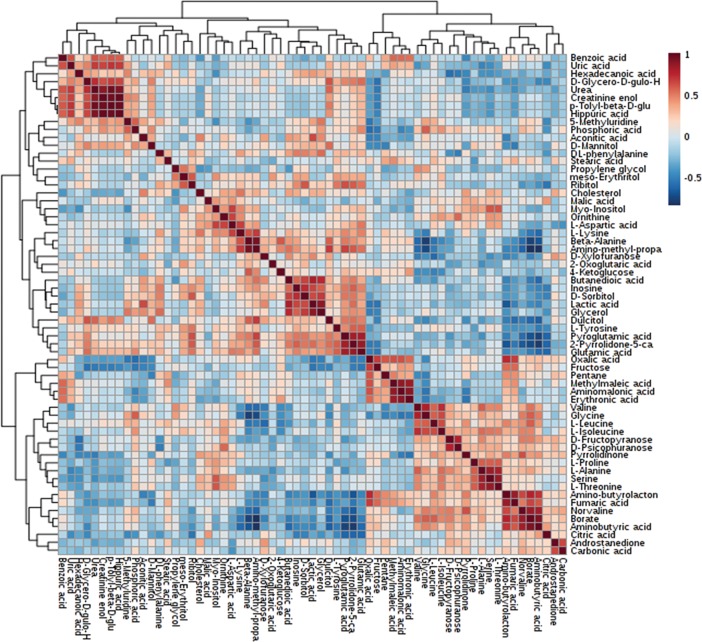
Heatmap of Pearson’s correlations among metabolites identified in bull seminal plasma.